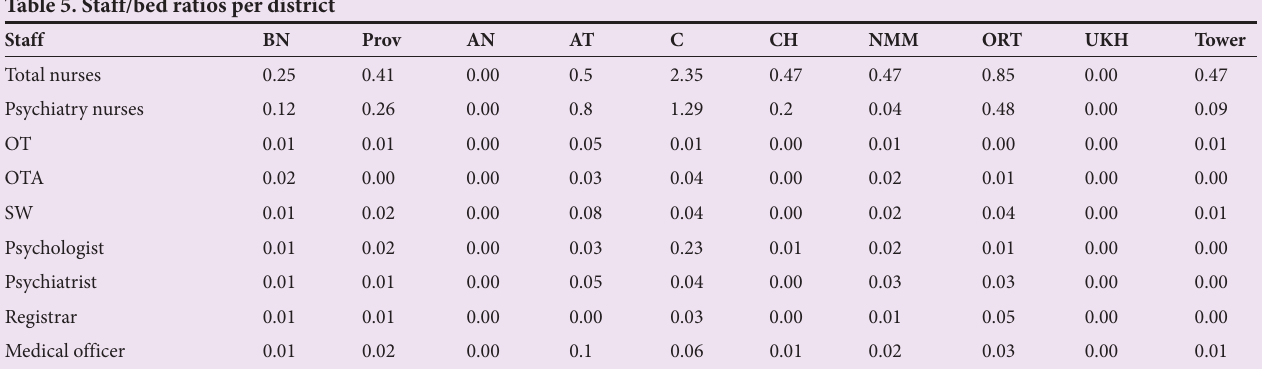
Table 5. Staff/bed ratios per